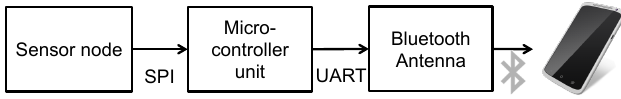
Figure 3. ECG signal measurement and